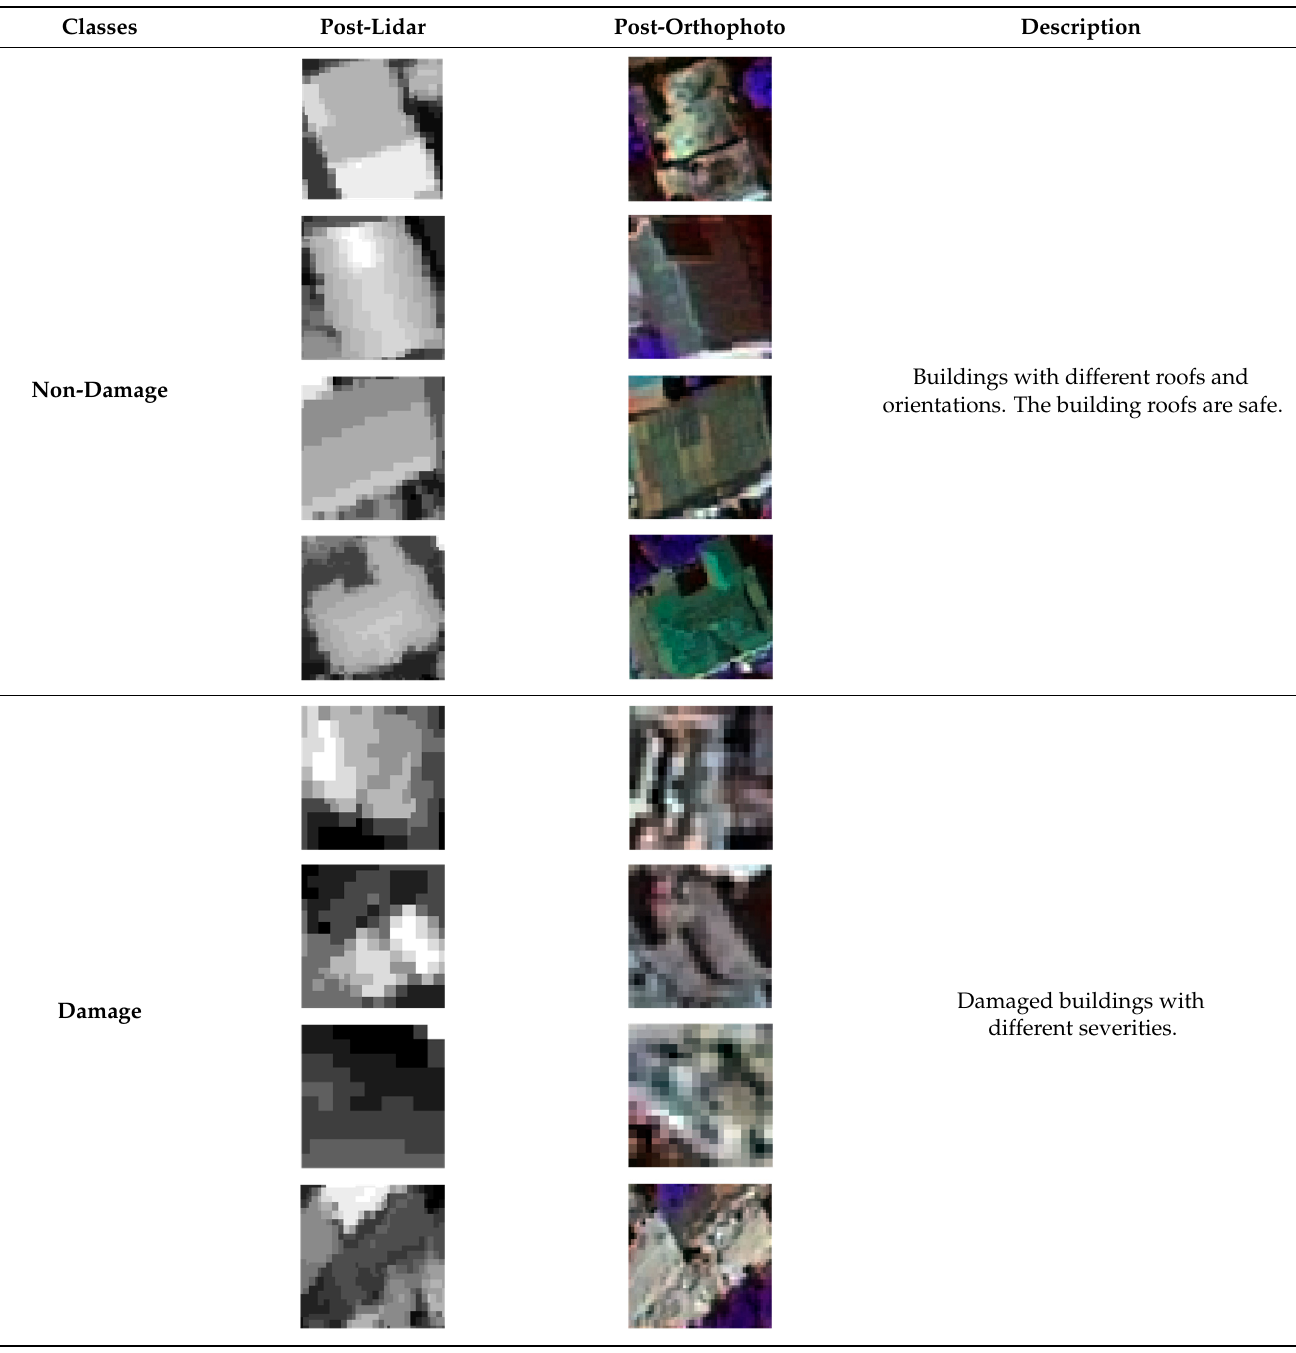
Table 2. A detailed description of different classes is available in the orthophoto image and Lidar.